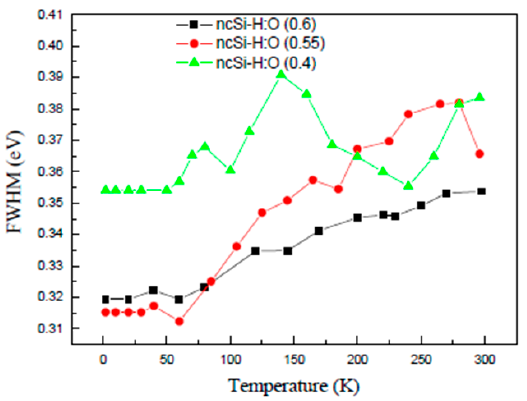
Figure 4. Plots of full-width at half maxima (FWHM) of PL for ncSi-H:O (0.6), ncSi-H:O (0.55) and ncSi-H:O (0.4), as a function of temperature.